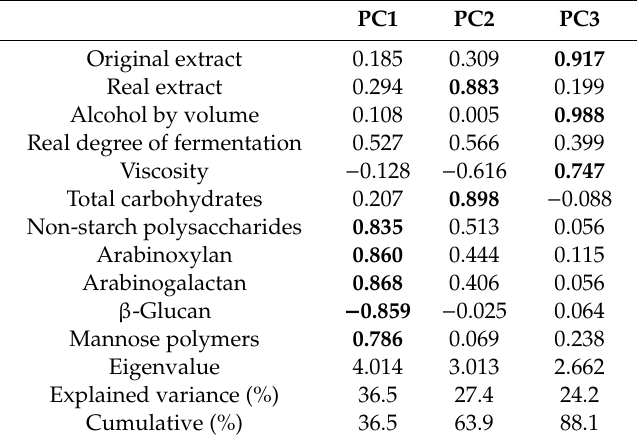
Table 6. Rotated principal component loadings of variables and evaluating indices.